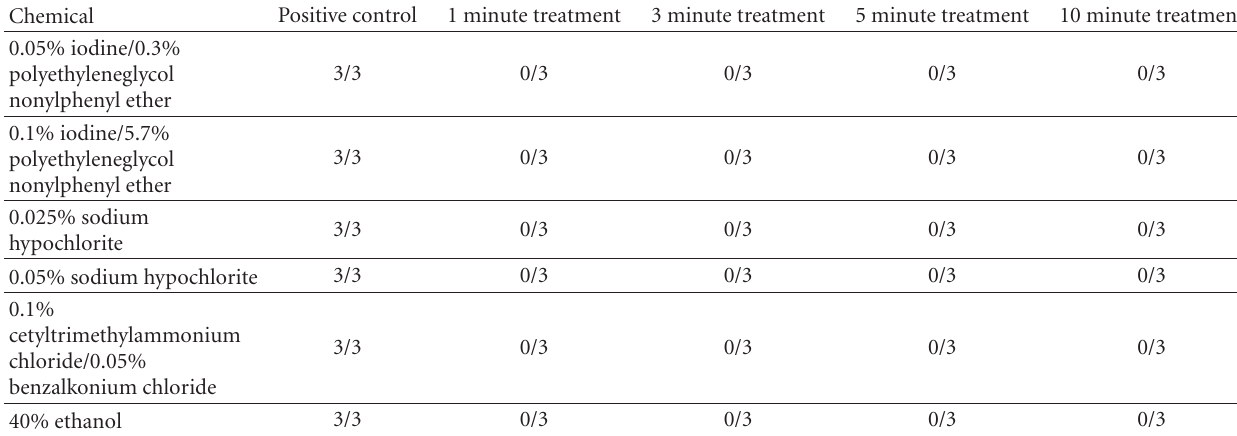
Table 2: The e ff ectiveness of disinfectants on fowlpox virus. Table 1 describes the number of plates (based on triplicate assays) with any wells showing cytopathic e ff ects or plaques.